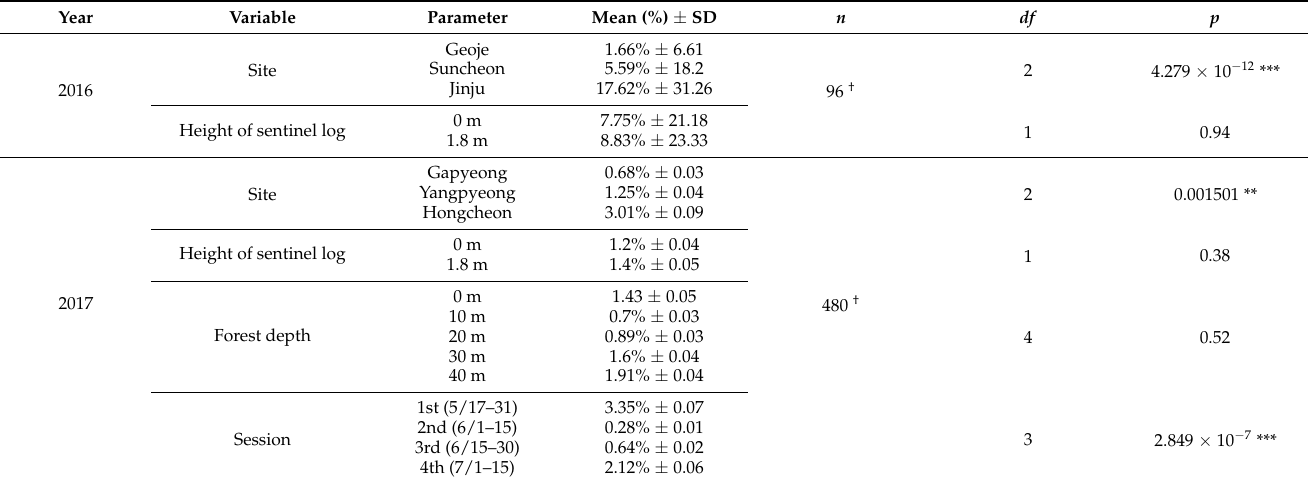
Table 3. Parasitism rate analysis of Spathius verustus by ecological variables using GLMM in 2016 and 2017.